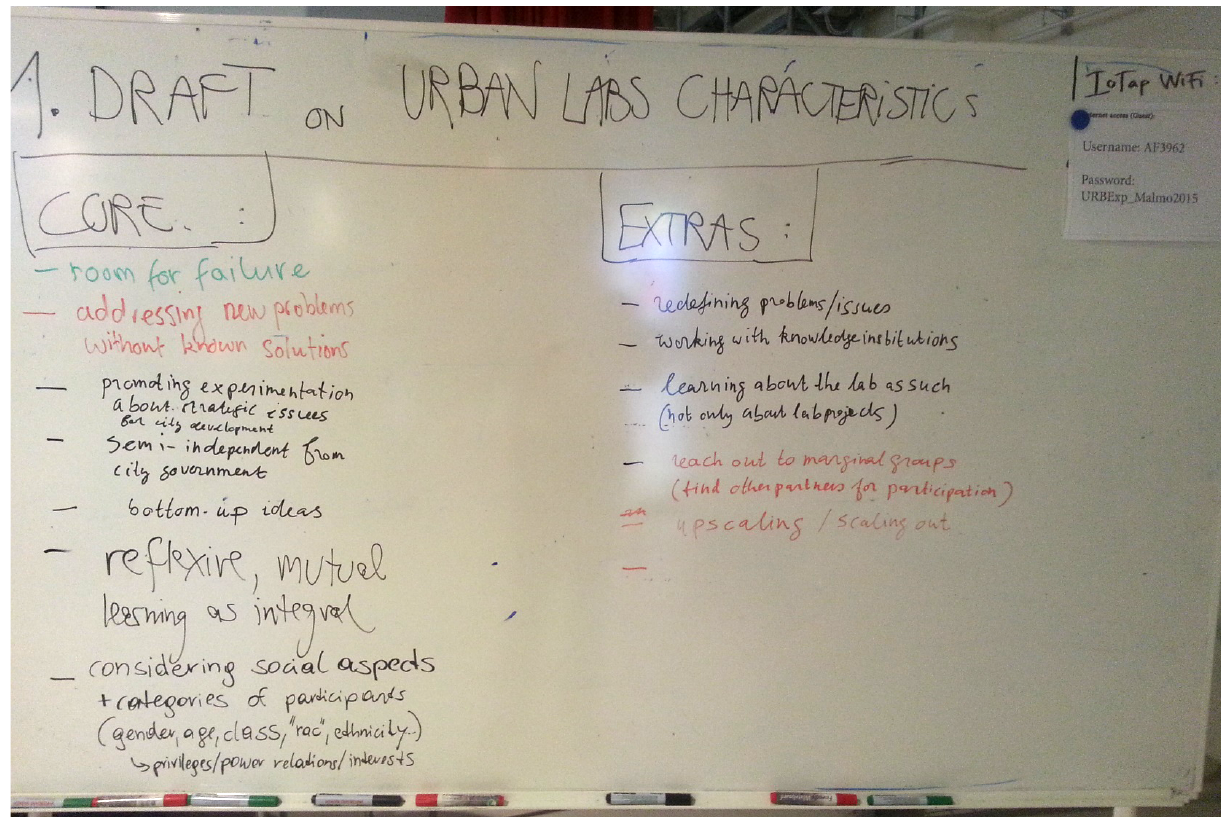
Figure 1. An early collective attempt at defining Urban Lab characteristics by URB@EXP researchers and practitioners. Picture from the URB@Exp project meeting in Malmö, March